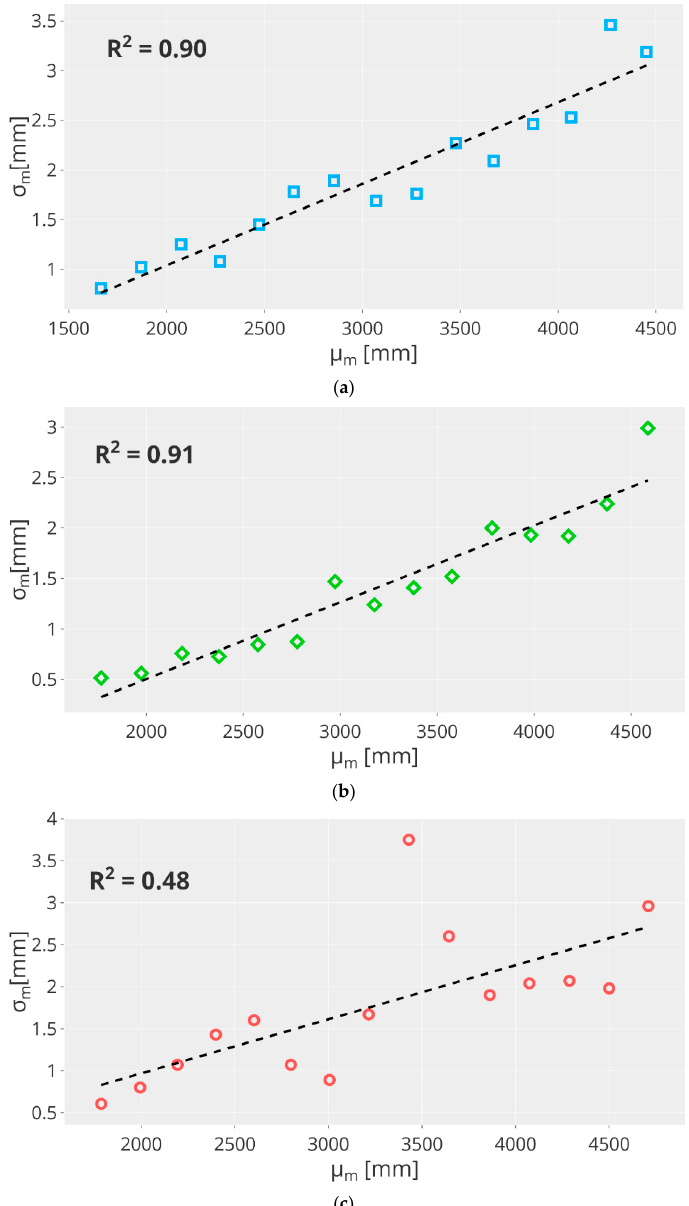
Figure 5. Plot showing the temporal error as a function of depth for ( a ) Kinect Azure, ( b ) Basler Blaze 101, and ( c ) Basler ToF